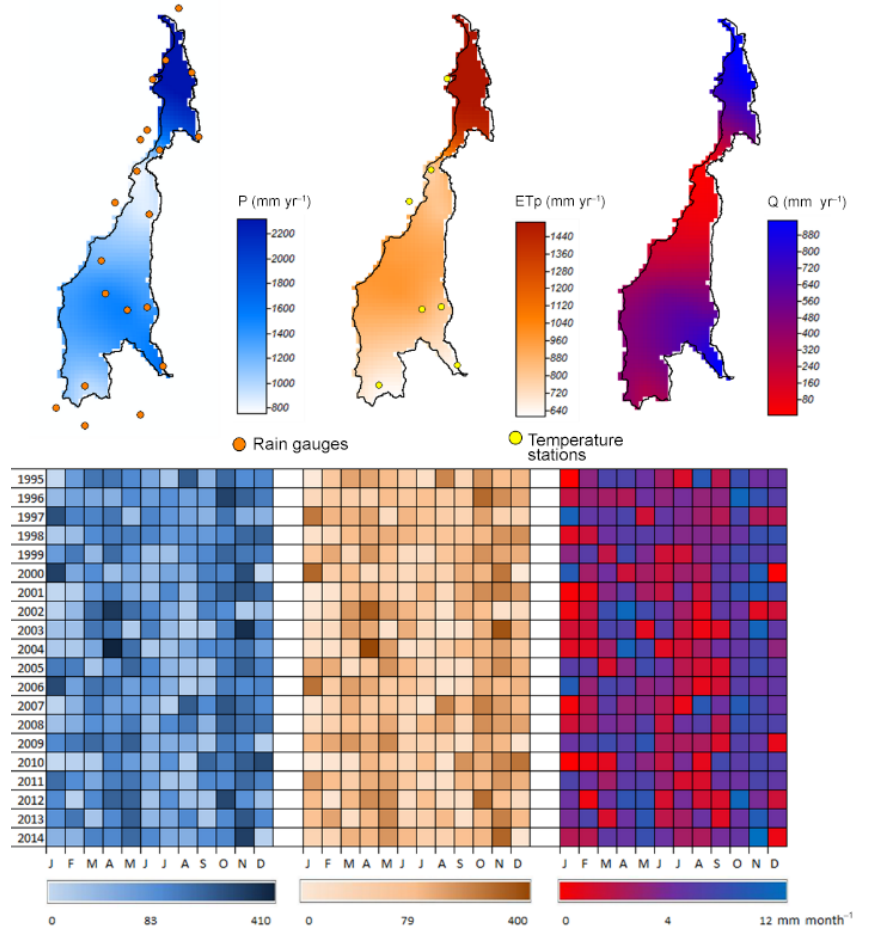
Figure 6. Annual and monthly water budget components for the Pamplonita’s river basin using SAGA